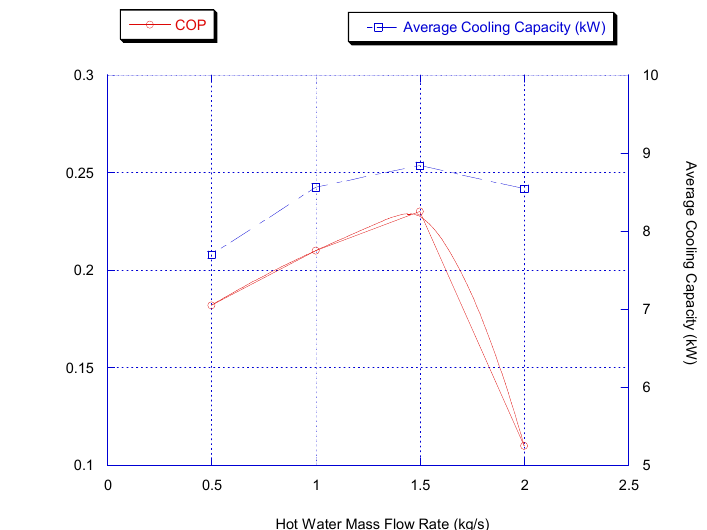
Figure 8. Effect of hot water flow rate on chiller average cooling capacity and COP (results are at chiller nominal operating conditions, shown in Appendix B).